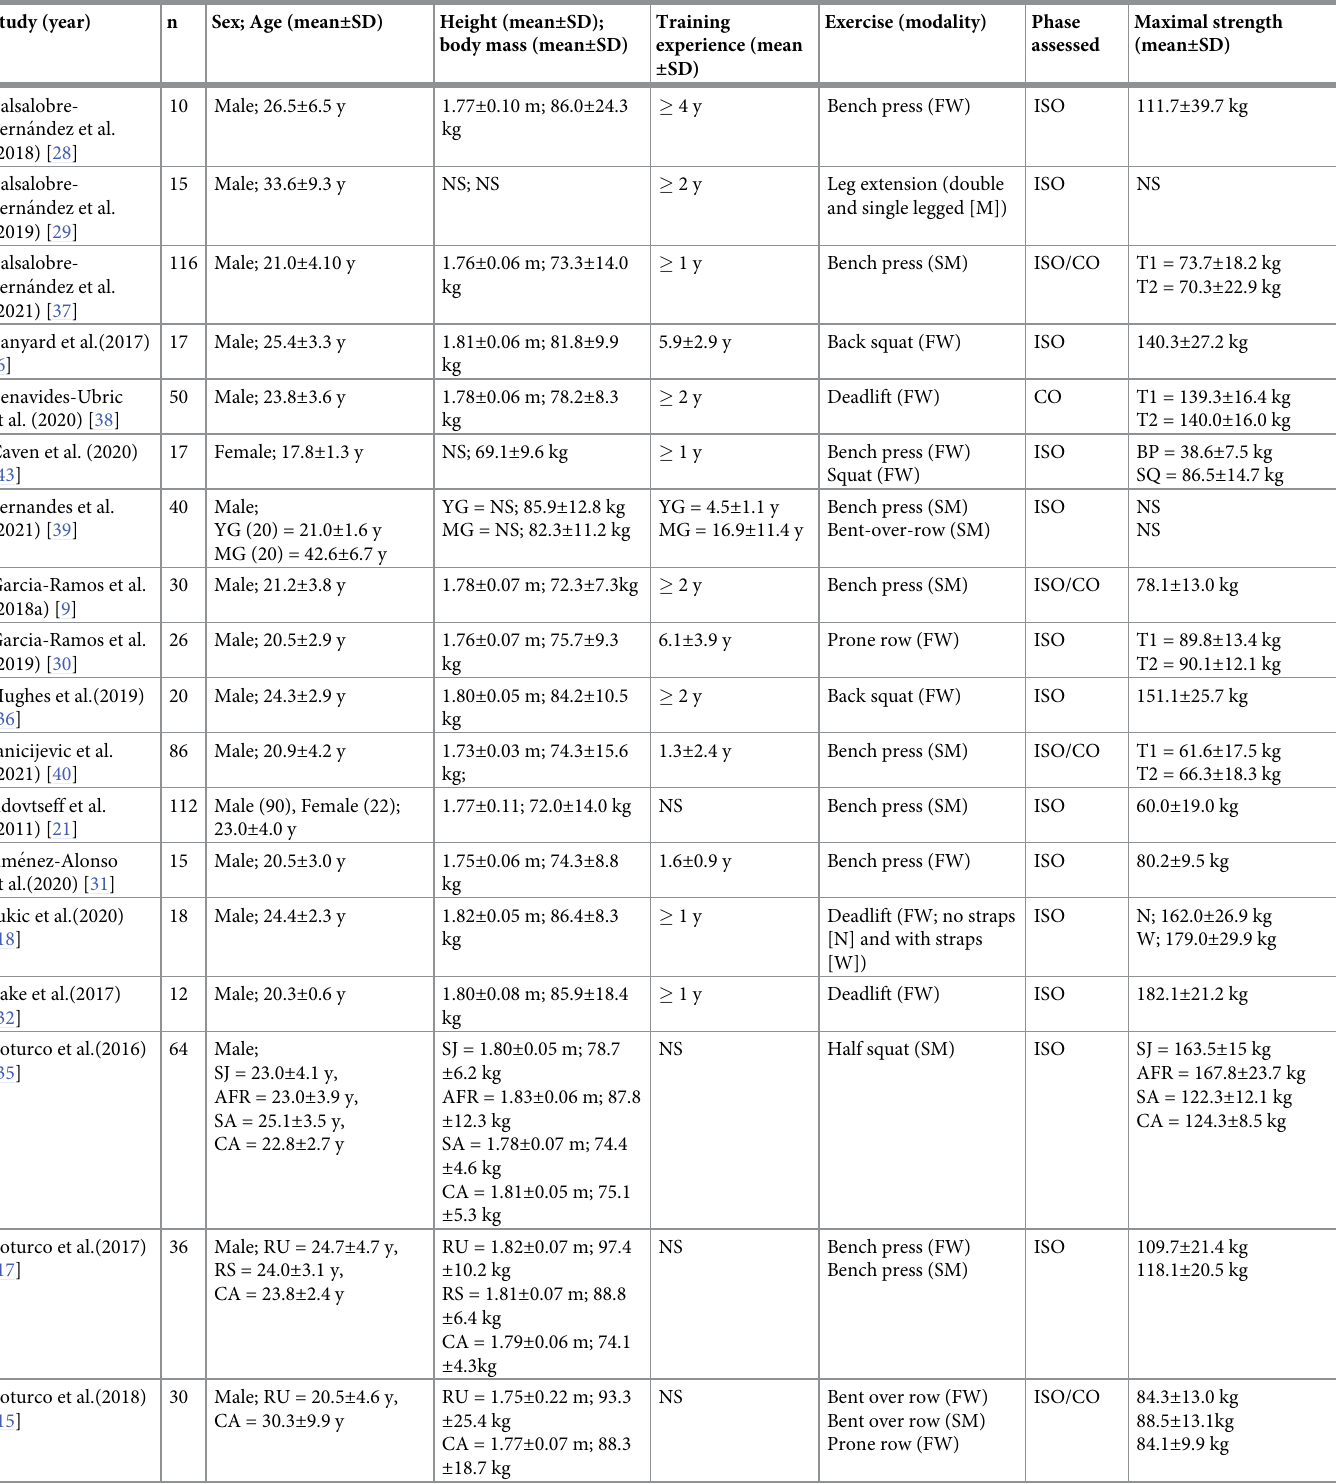
Table 3. Descriptive statistics of included